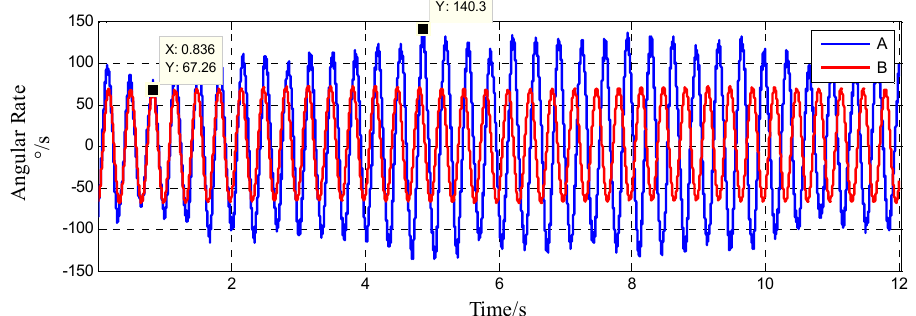
Figure 18. The comparison of the angular rate of axial gyroscope ω x inside the isolated rolling platform.